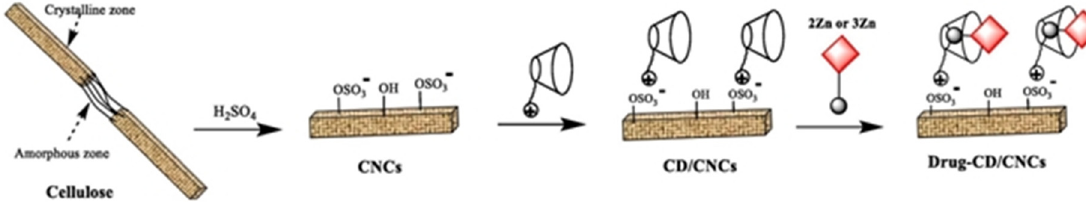
Figure 12. General strategy of CNCs synthesis and encapsulation of 2Zn and 3Zn by CD/CNCs [92] .